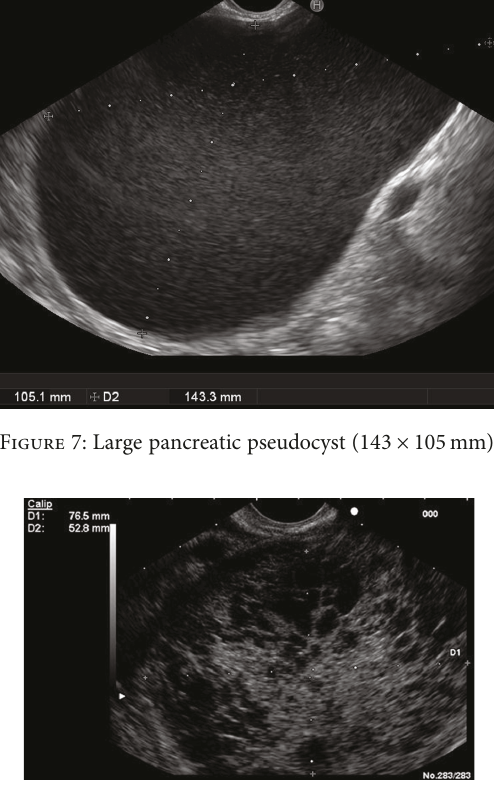
Figure 8: Solid-cystic pseudopapillary